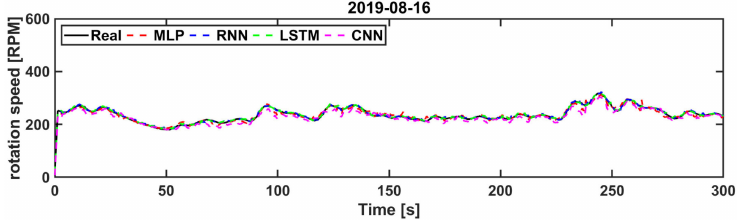
Figure 20. Comparison of the prediction performances of each algorithm for the conditions of Case 6 (training datasets: 26 April 2019, 20 July 2019, 16 August 2019; test dataset: 16 August 2019).